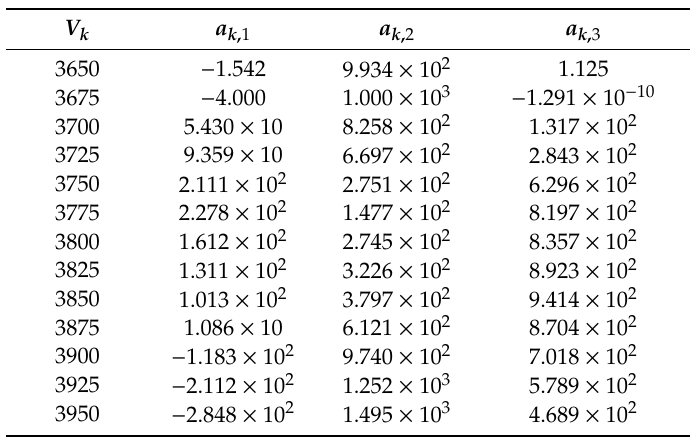
Table 3. Estimated parameters in the battery